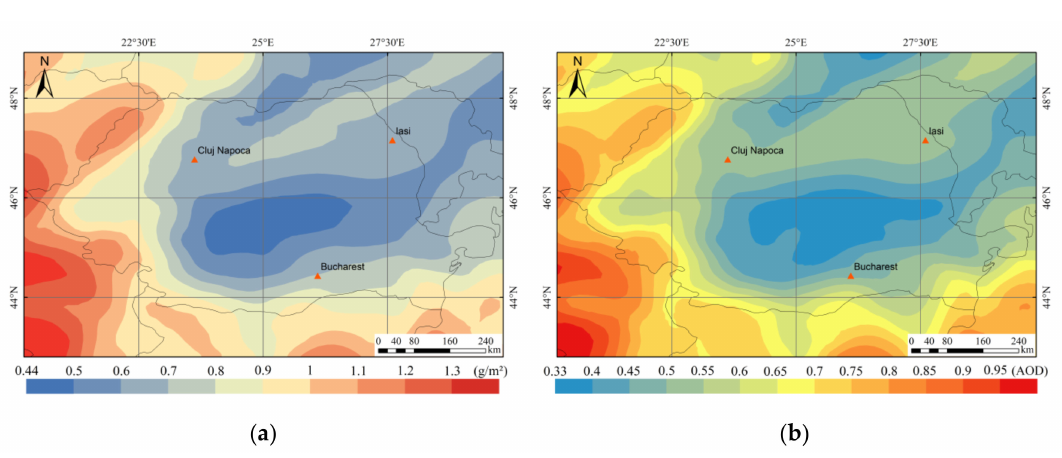
Figure 5. The distribution of the absolute maximum values of DL ( a ) and AOD ( b ) over Romania between December 2015–February